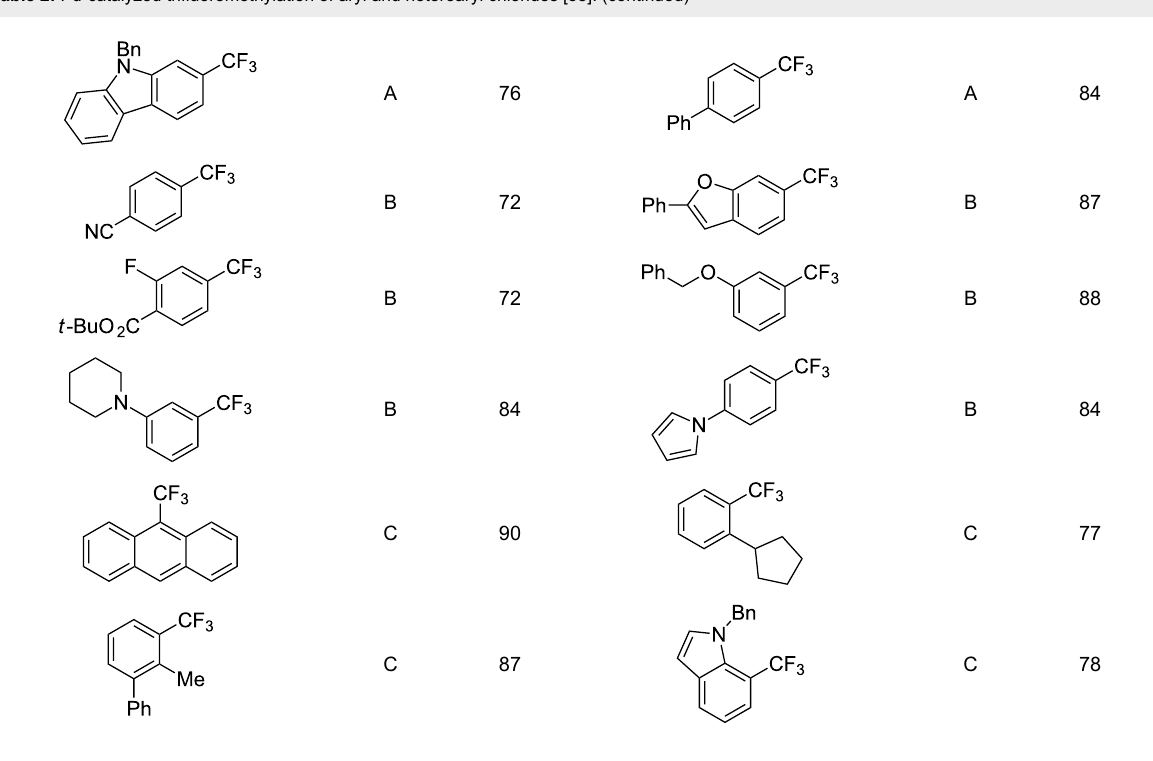
Table 2: Pd-catalyzed trifluoromethylation of aryl and heteroaryl chlorides [38]. (continued)